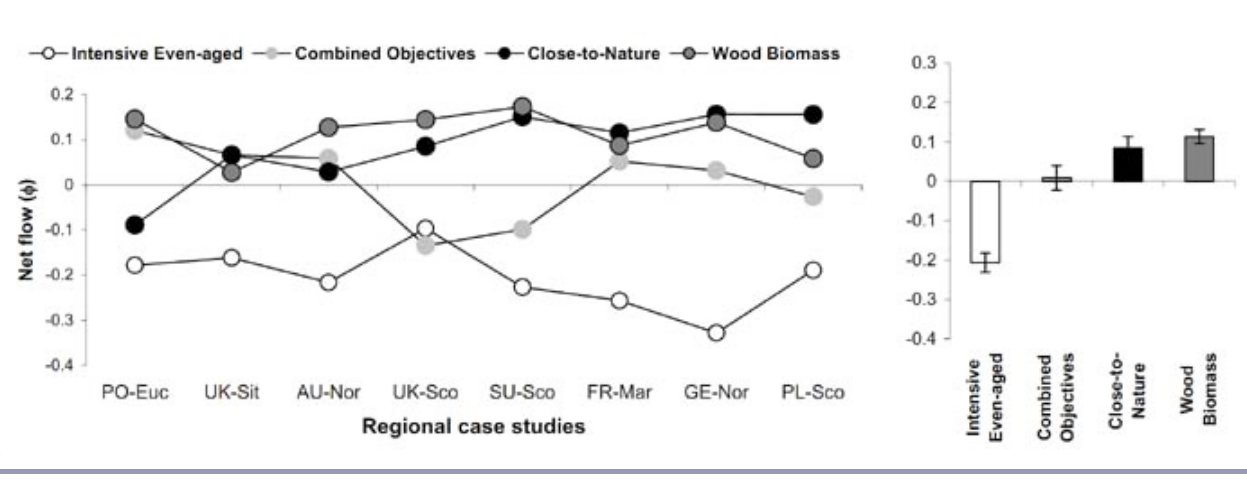
Fig. 3. Ranking of FMAs according to vulnerability to biotic and abiotic hazards, i.e., irrespective of hazard occurrence (equal weights in MCRA) across eight different regional case studies (left-hand side) and for overall results (right-hand side).